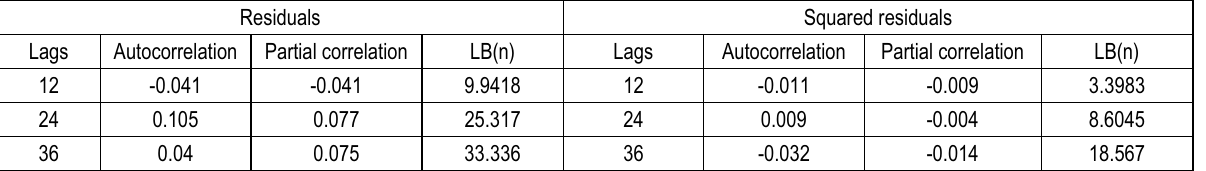
Table 4 (cont.). Diagnostics on standardized and squared standardized